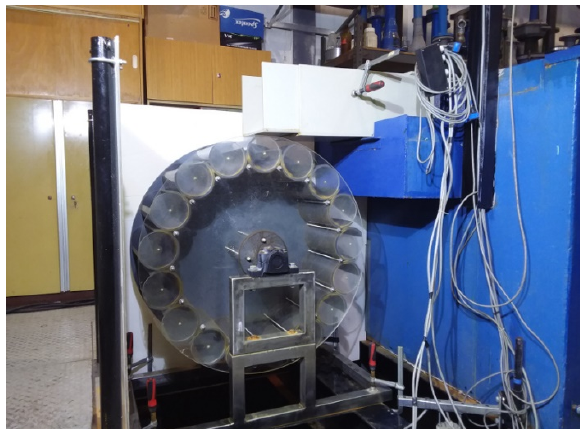
Fig. 15. Tested water